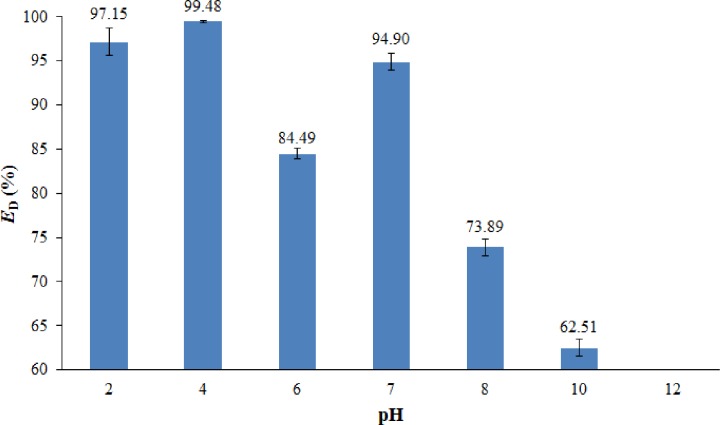
Effect of the crude O/W emulsion pH on ED.